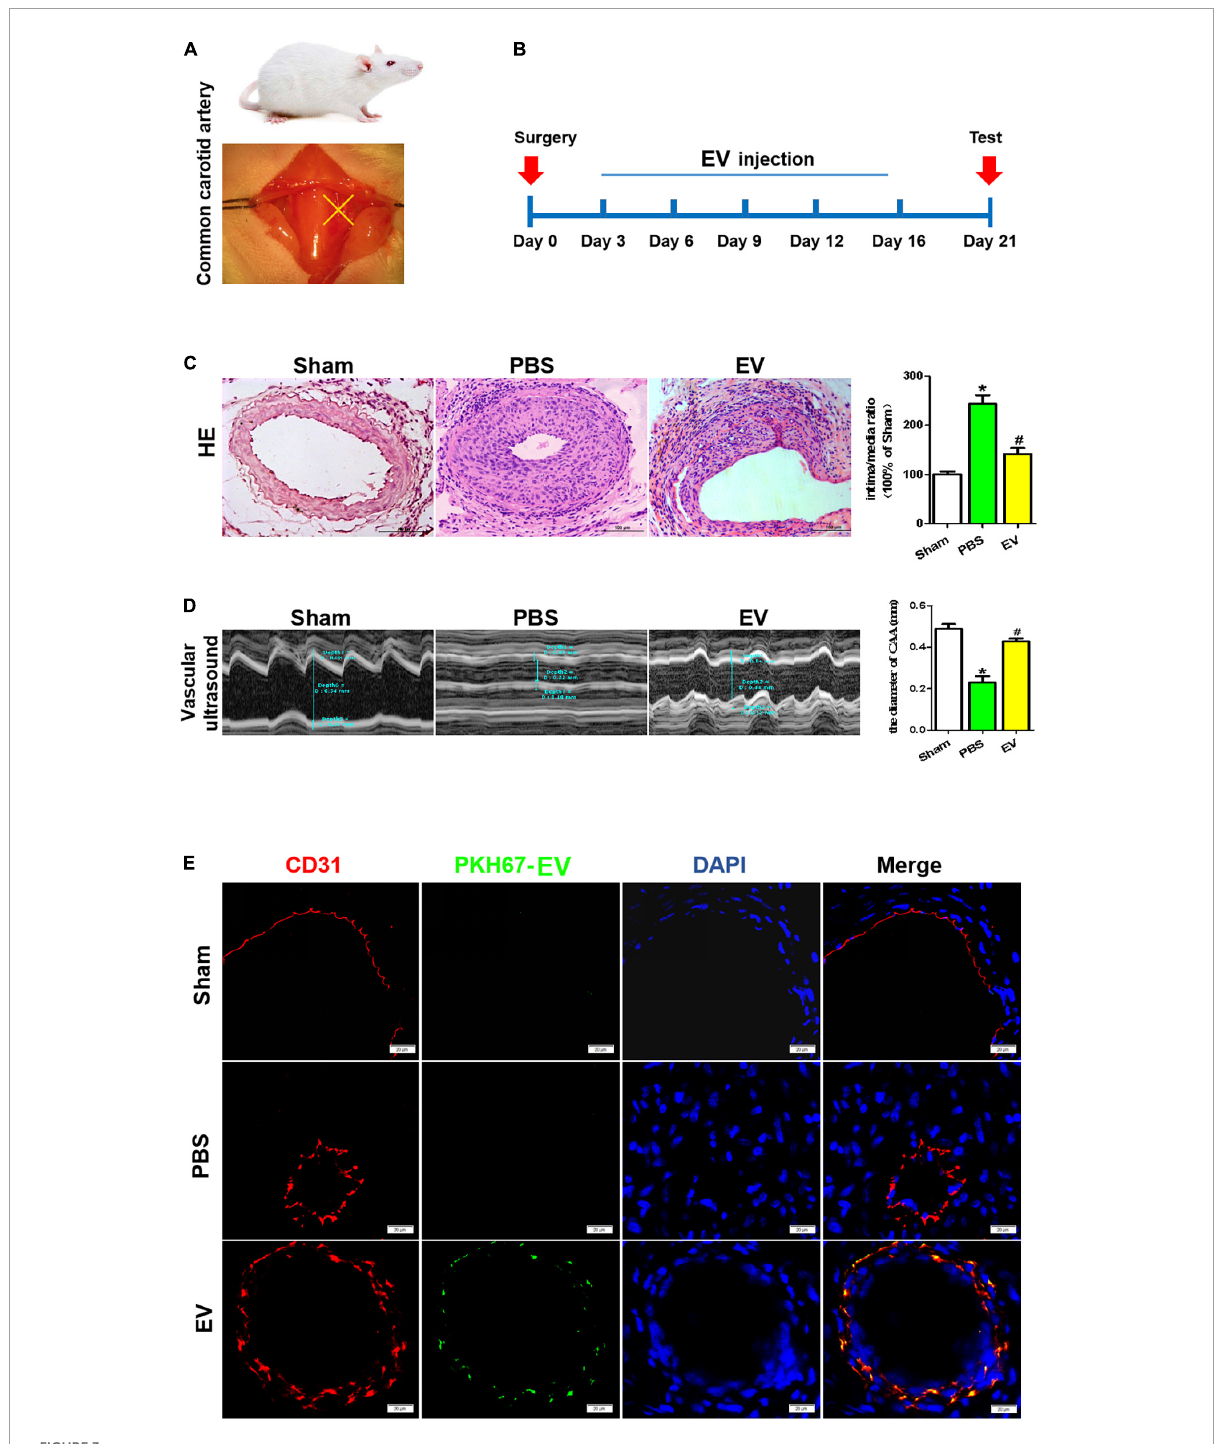
FIGURE3 Arterial stenosis of carotid artery is reduced by exposure to human-induced pluripotent stem cell- endothelial cell-extracellular vesicle (hiPSC-EC-EV). (A) Schematic illustration of the carotid artery ligation procedure in the mouse model. (B) Time chart for the in vivo treatment of the vascular tissue with hiPSC-EC-EV and its collection for testing. (C) Analysis of the neointimal hyperplasia formation in the hiPSC-EC-EV-treated vs untreated mice 21 days after surgery by HE staining, and quantification of the intima-to-media ratio in the blood vessels. Scale bar = 100 µ m. (D) Representative ultrasound images of the lumen size in the carotid arteries 21 days after the surgery and statistical analysis of the differences. (E) Representative images of ECs immunofluorescently stained for CD31 and PKH67 in the carotid arteries 21 days after the surgery. Data represent mean ± SD from three independent experiments ( n = 3). Differences between linked groups were evaluated by a two-tailed Student’s t- test. * p < 0.05 vs. Sham, # p < 0.05 vs.